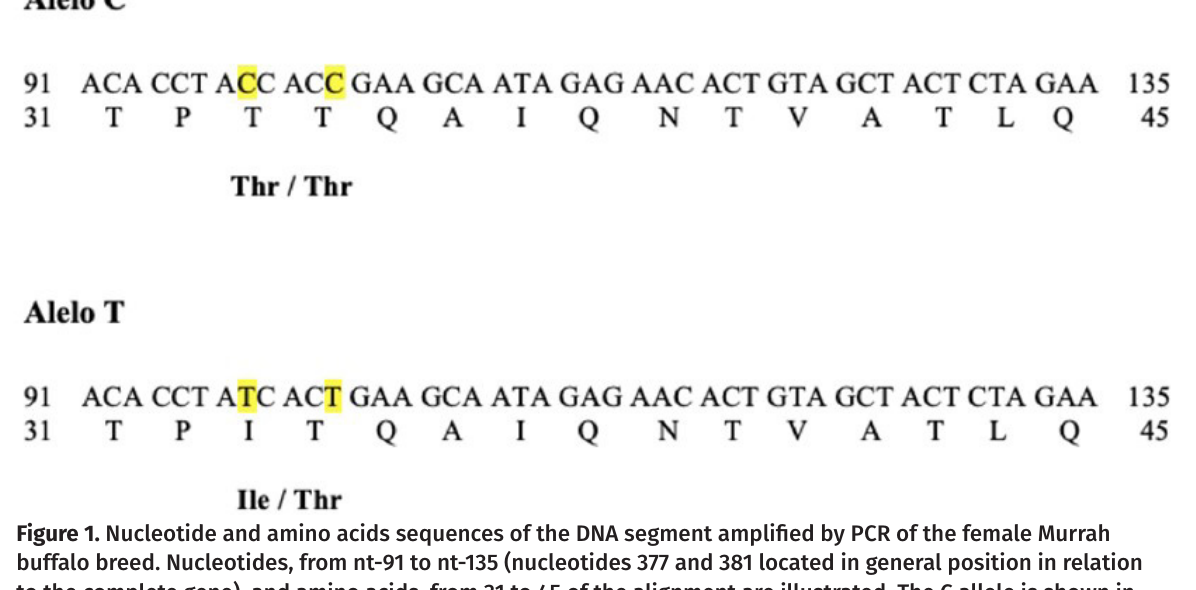
Figure 1. Nucleotide and amino acids sequences of the DNA segment amplified by PCR of the female Murrah buffalo breed. Nucleotides, from nt-91 to nt-135 (nucleotides 377 and 381 located in general position in relation to the complete gene), and amino acids, from 31 to 45 of the alignment are illustrated. The C allele is shown in codons 33 threonine (Thr) (ACC) and 34 Thr (ACC), while the T allele is shown in codons 33 isoleucine (Ile) (ATC) and 34 Thr